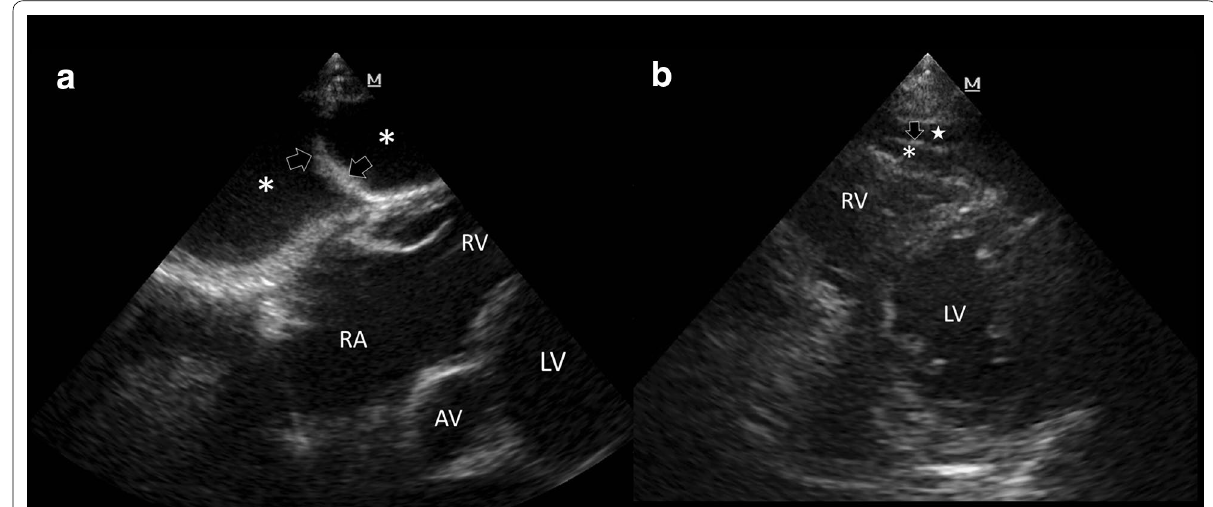
Fig. 2 a Pericardial effusion versus ascites. Ascites ( asterisks ) is shown anterior to the heart in subcostal 4-chamber view. The falciform ligament ( arrows ) is depicted, confirming this effusion. LV left ventricle, AV aortic valve, RV right ventricle, RA right atrium. b Epicardial ( asterisk ) and mediasti- nal fat ( white star ), demonstrated in parasternal short-axis view, in systole; LV left ventricle, RV right ventricle, arrow pericardium